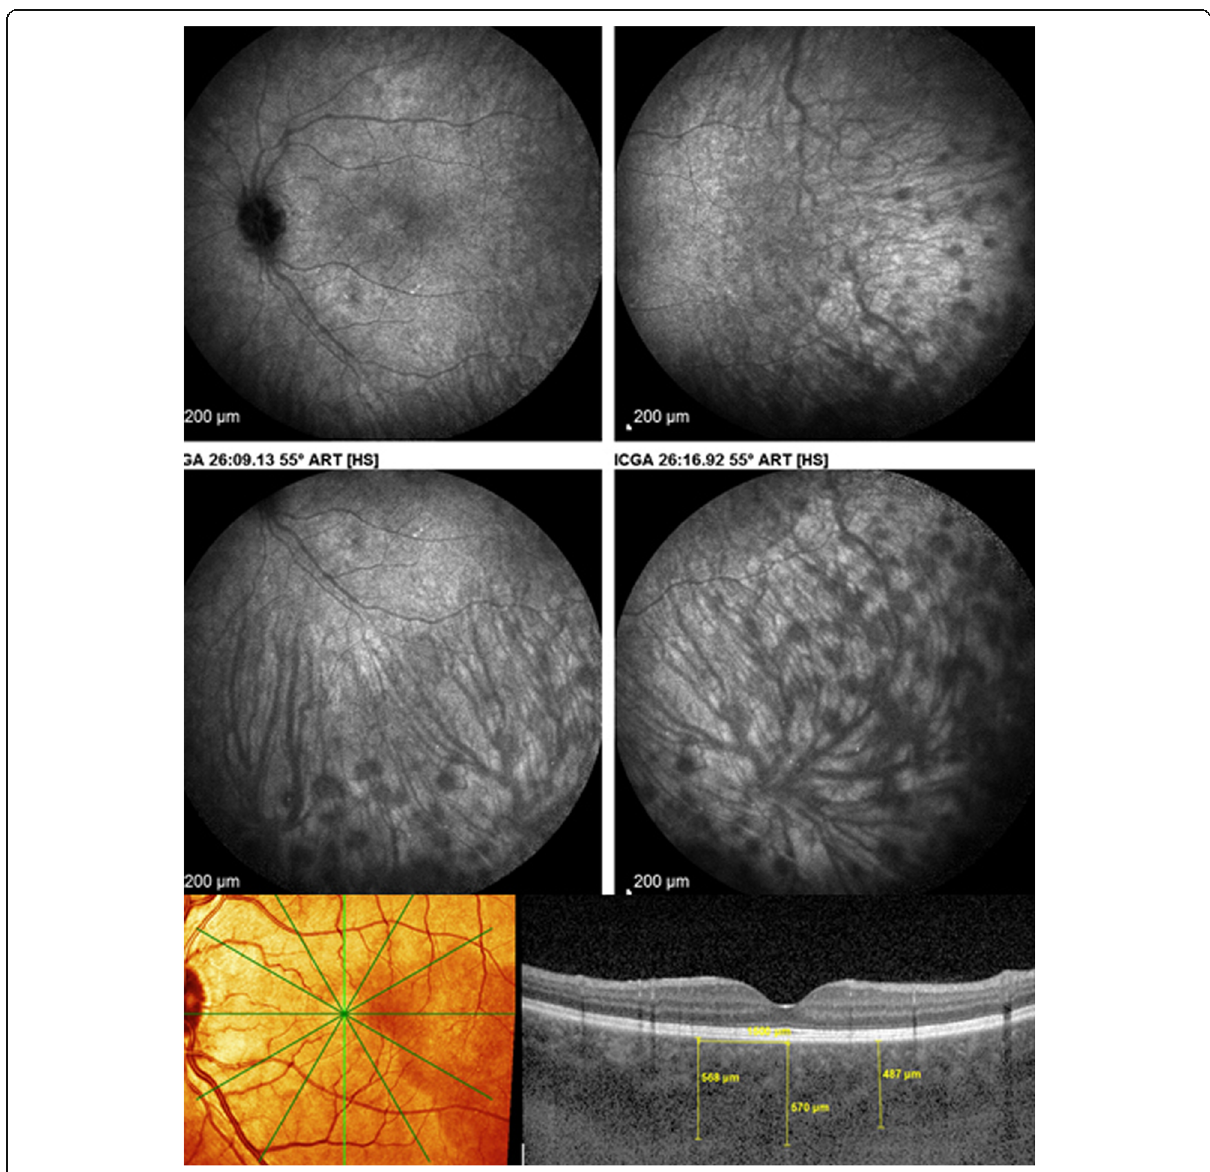
Fig. 12 EDI measurement of choroidal thickness in a case of VKH disease. Numerous HDDs are shown in the top quartet of frames, that cause choroidal thickening which can be measured (bottom